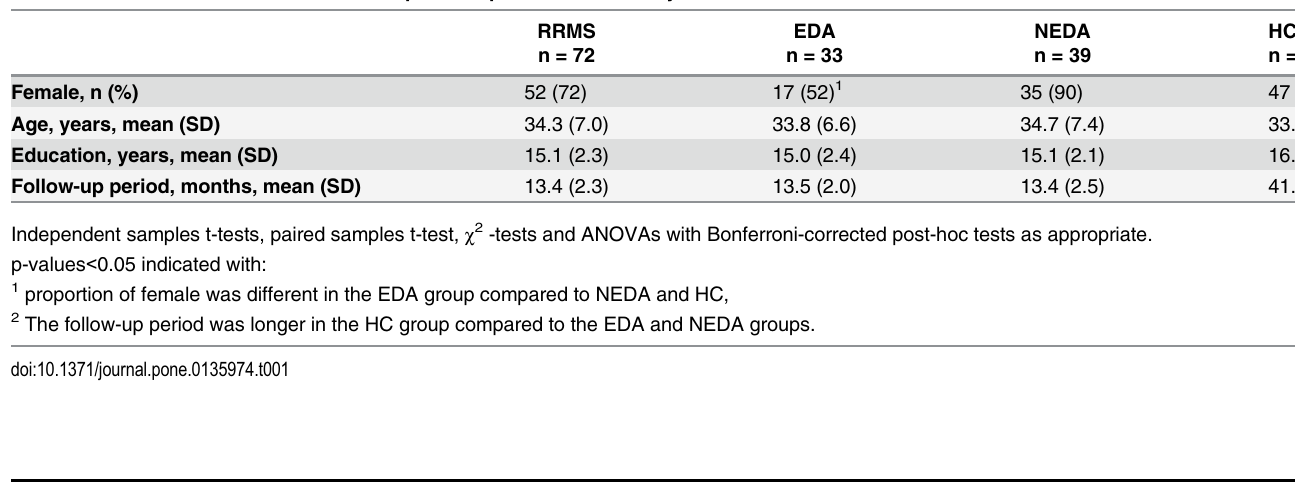
Table 1. Baseline information and follow-up time of patients and healthy